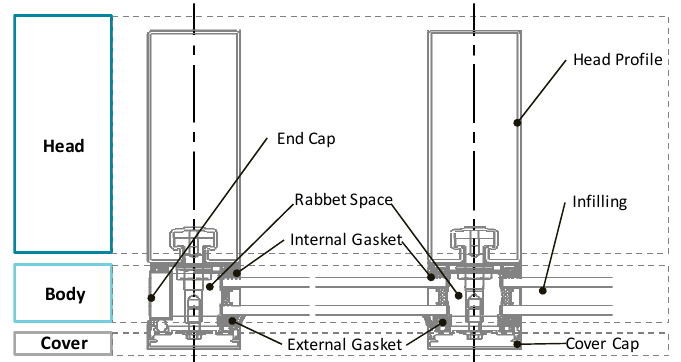
Figure 3. Description of curtain-wall system.